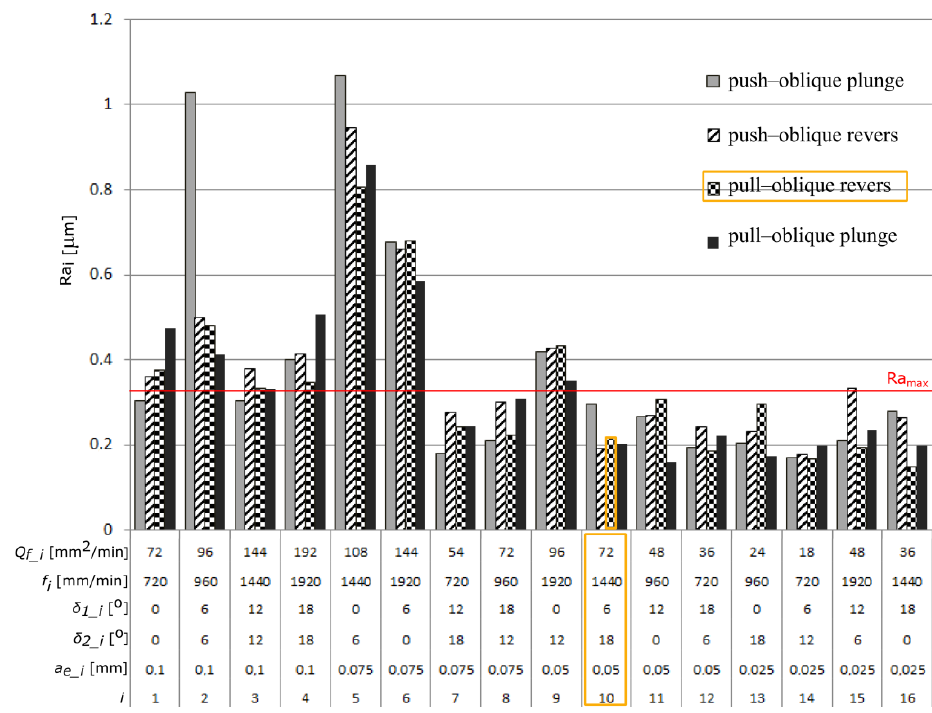
Figure 8. The average values of the surface roughness parameter Ra measured during the tests.